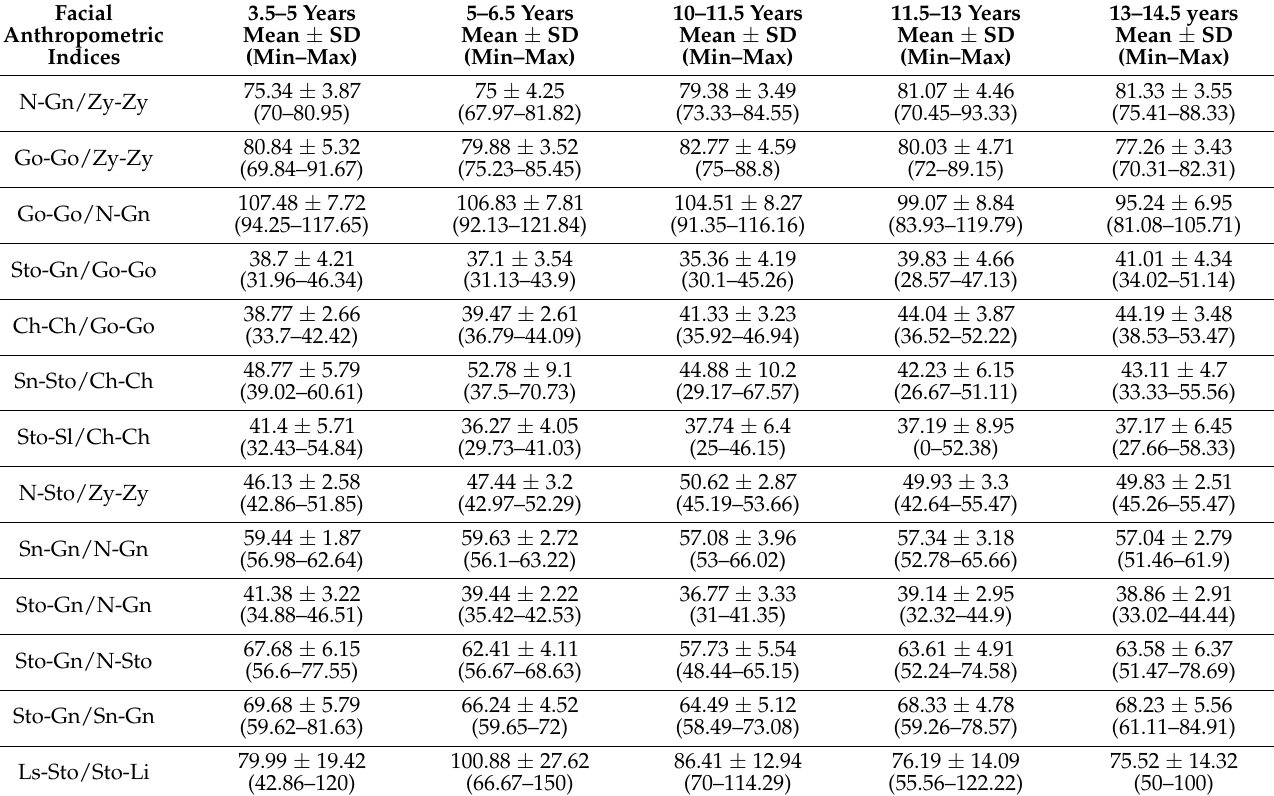
Table 3. Facial anthropometric indices in our study on different age